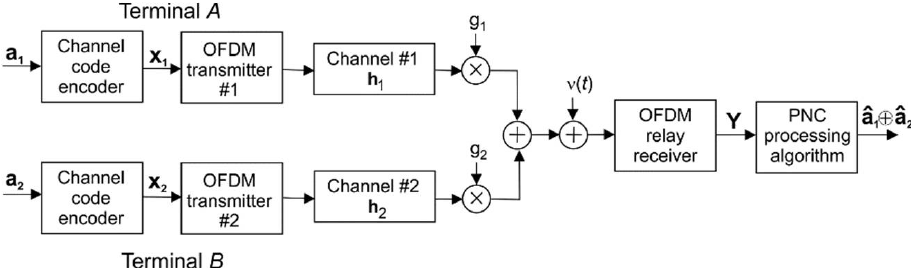
Figure 3. General scheme of a two-way relaying PNC system in the multiple access phase. For the sake of simplicity, we assume that the channel impulse responses have unit energy, and we model the unequal power of the signals reaching the relay using the weighting coefficients g 1 and g 2 . To model the propagation loss, we assign the power P i ( i = 1, 2) of signals incoming to the receiver from each user by setting the values of the ν ( t ). In this paper, we assume that signals from both transmitters arrive at the receiver